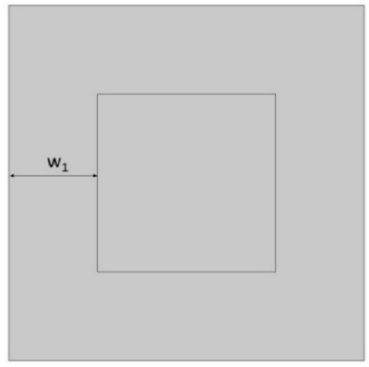
Figure 5. Distance between the outer and inner square in the unit.